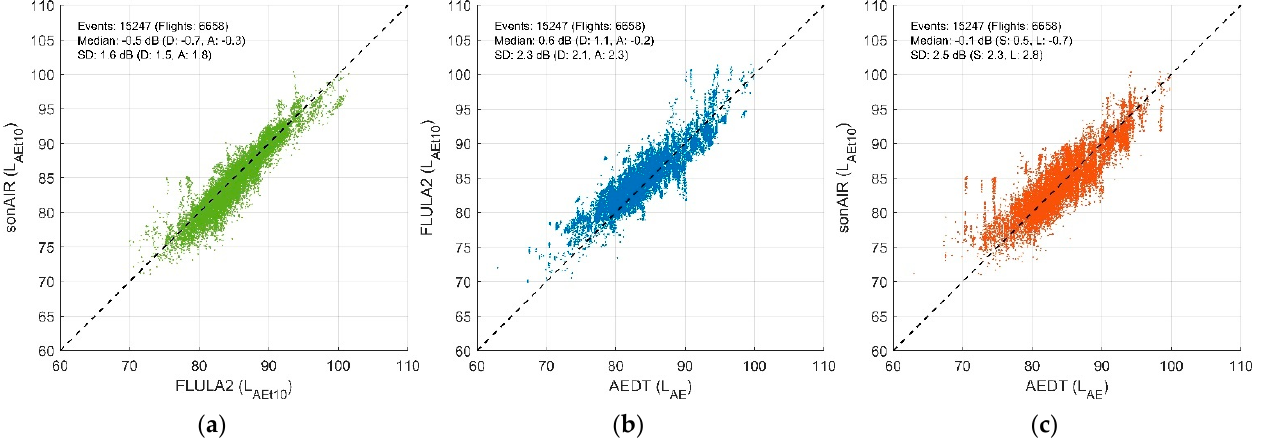
Figure 9. Scatter plots of the calculated event levels L AE, t10 (L AE for AEDT) between the three models for aircraft without FDR data in the close range (ZRH and GVA combined), grouped by procedure (D: Departure, A: Approach, SD: Standard deviation). ( a ) sonAIR vs. FLULA2; ( b ) FLULA2 vs. AEDT; ( c ) sonAIR vs. AEDT.